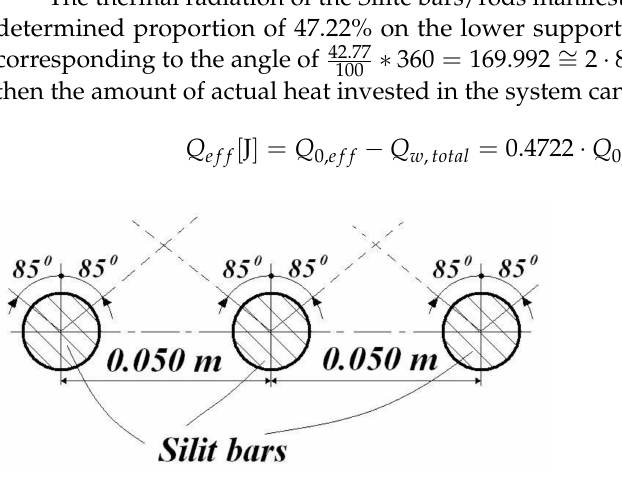
Figure 7. Position of the Silite